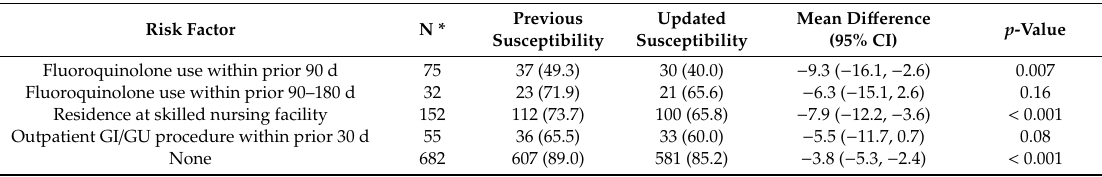
Table 2. Mean di ff erence in ciprofloxacin susceptibilities for Enterobacteriaceae by previous and updated breakpoints based on risk factors for fluoroquinolone resistance.